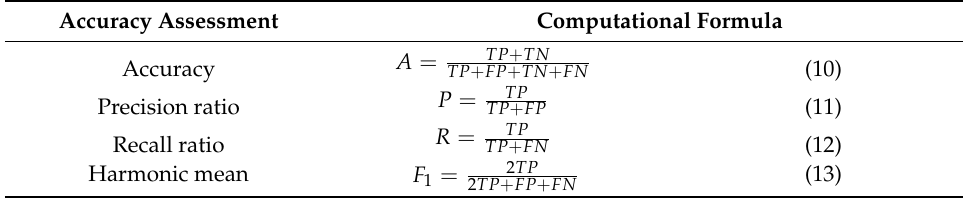
Table 2. Accuracy assessment of SVM binary classification.